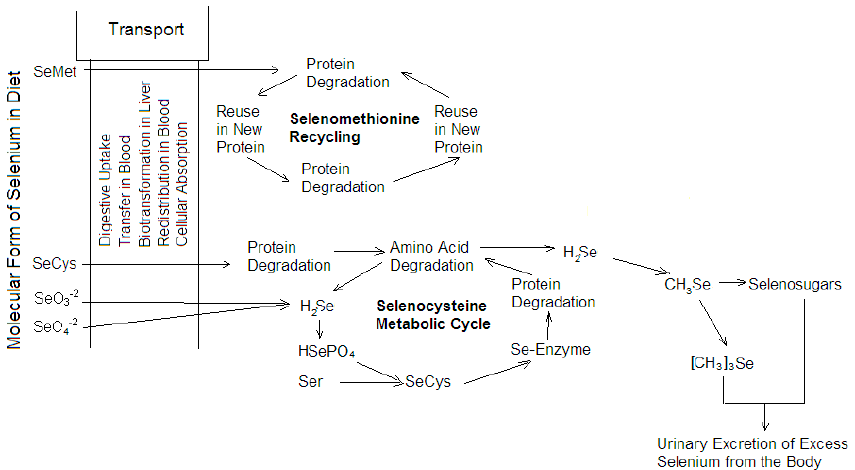
Figure 3. Selenium metabolism. Modified from Ralston et al. [35].